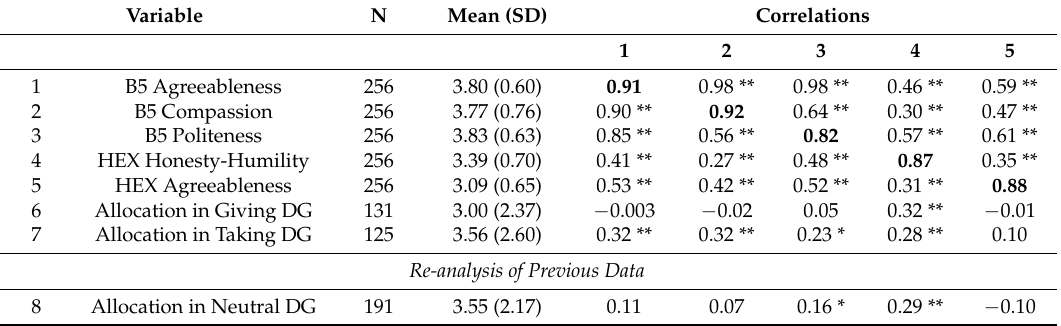
Table 1. Descriptive statistics and bivariate correlations between prosocial traits and dictator